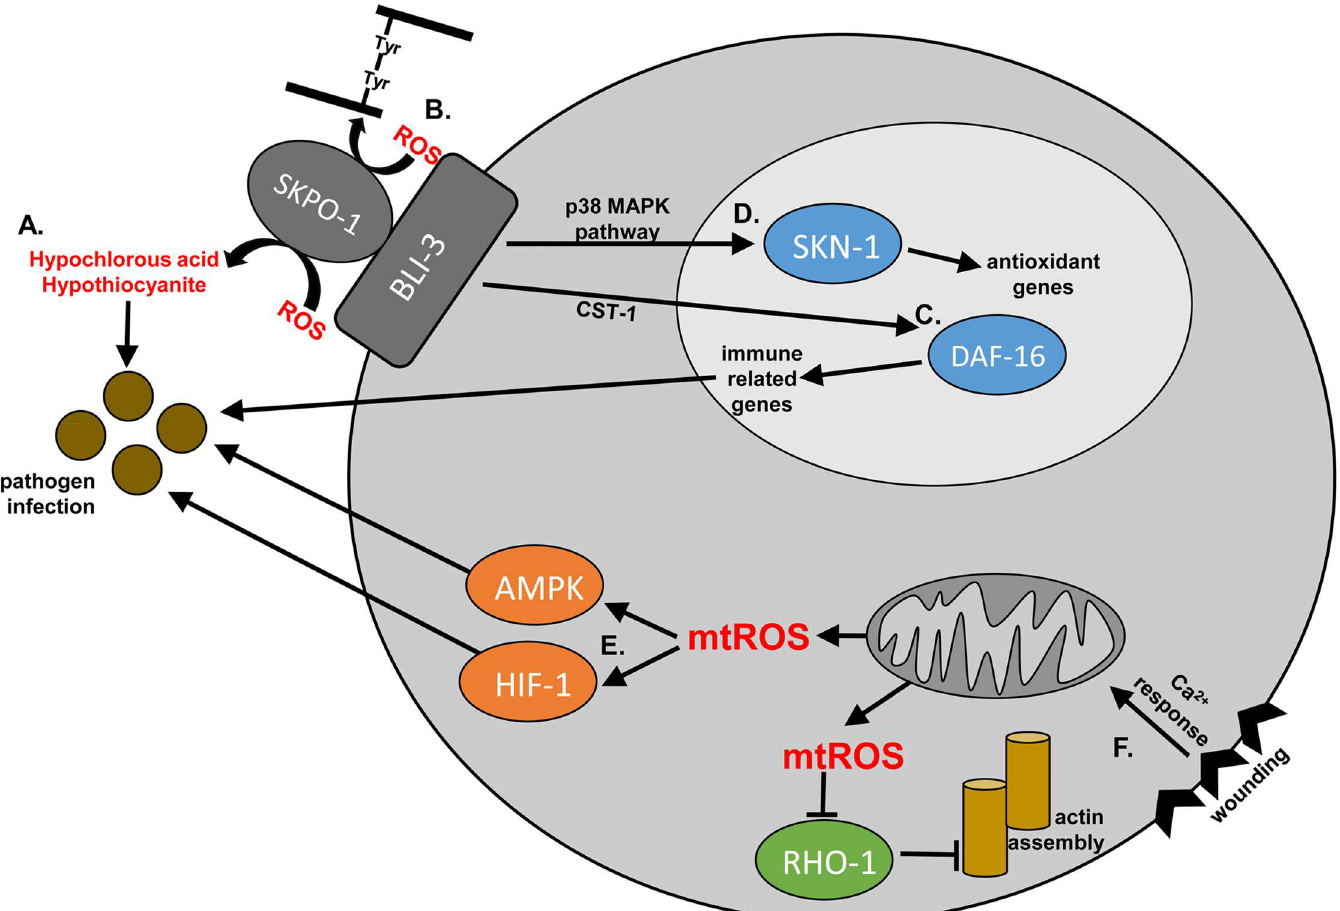
Fig 1. Possible mechanisms by which ROS are protective during infection. During pathogeninfection, BLI-3-generated ROS may be utilized (A) by SKPO-1 to generate more potent antimicrobials (B) to maintain protective barriers; (C) to activate DAF-16, via oxidationof CST-1, to increase the expressionof protective immune response genes; and/or (D) as a signalingmoleculeto activate SKN-1, via the p38 MAPK pathway, to maintain redox homeostasisduring infection. Alternatively, pathogen infection stimulates the release of mitochondrial ROS (mtROS). These mtROS (E) facilitate HIF-1 and AMPK-dependent immunity. (F) Alternatively, during infection, wounding-dependent release of calcium causes mtROS release, relieving repressionof protective actin assembly via oxidationof